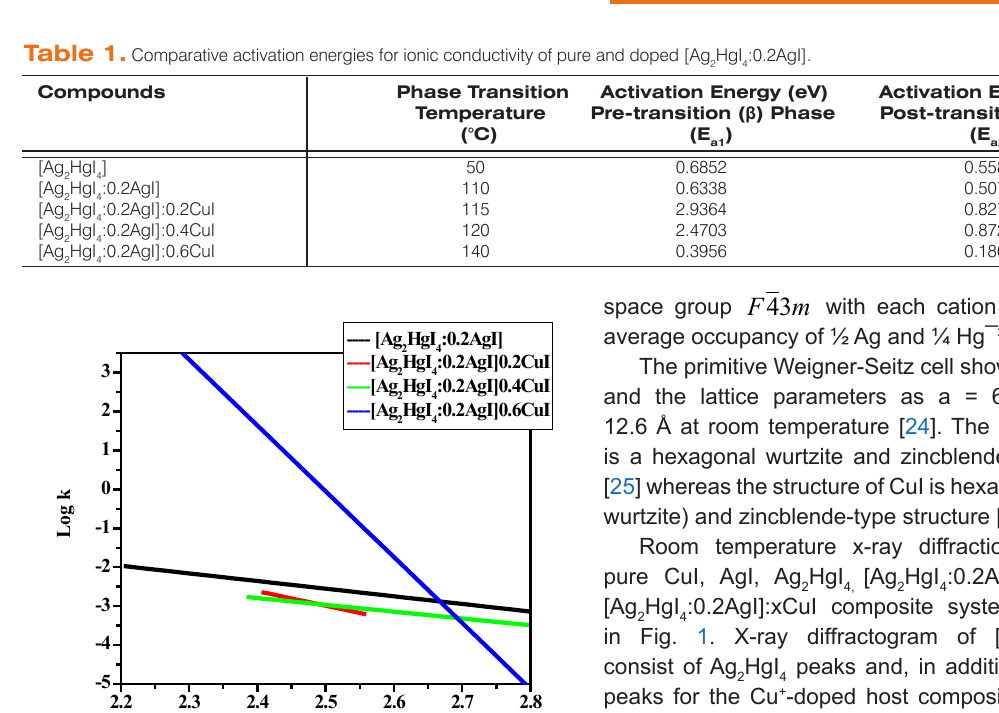
Figure 5. X-ray diffractogram fo r [Ag where (x = 0.2, 0.4, 0.6 mol. wt.%).